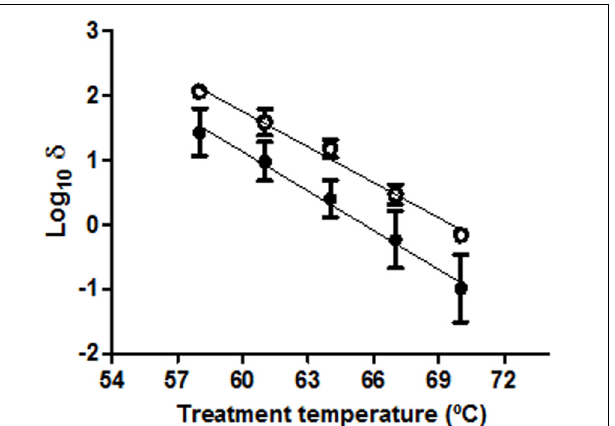
FIGURE 3 | Log 10 times for the decimal reduction of E. coli BW25113 at different treatment temperatures in M9 broth and recovered in M9 agar added with 3% NaCl in the absence ( betaine. Error bars represent standard deviation of the mean from three